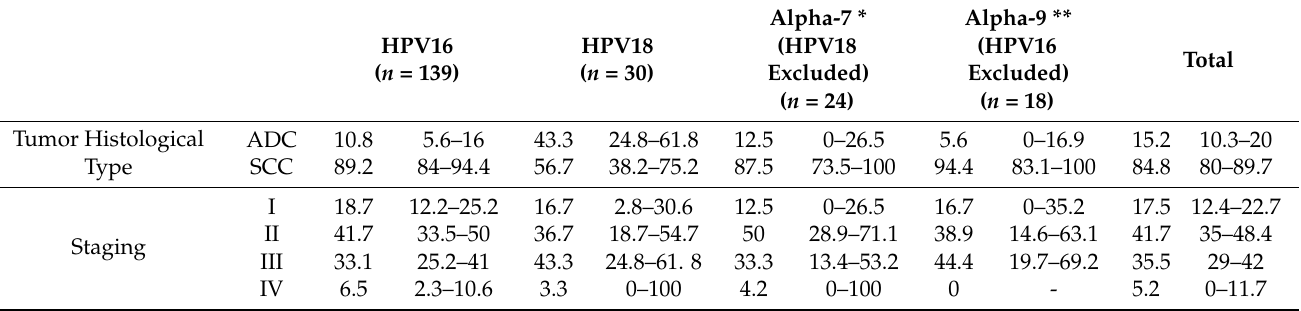
Table 1. Clinical characteristics of women with cervical cancer followed in the study according to infecting HPV type